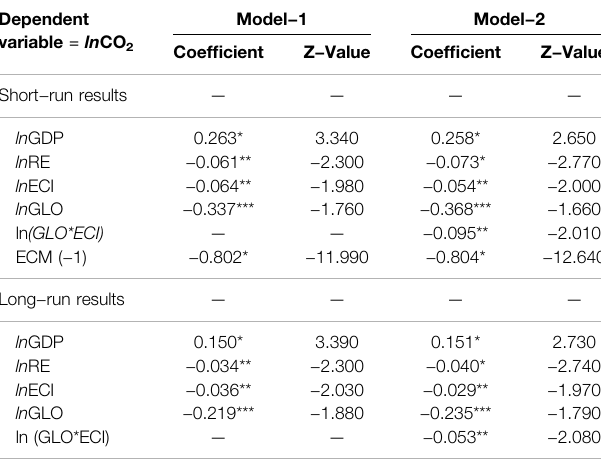
TABLE 6 | CS − ARDL test